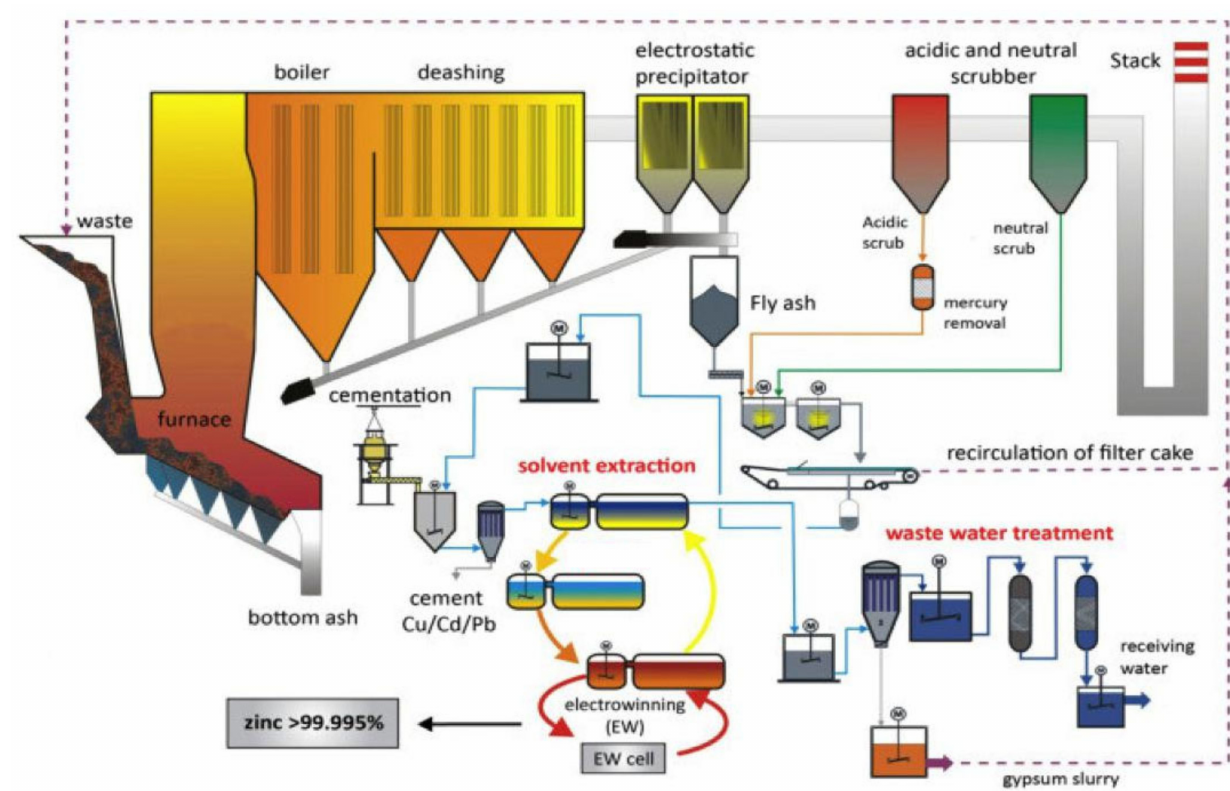
Figure 4. Procedure diagram of incineration fly ash [56]. Reprinted with permission from MDPI